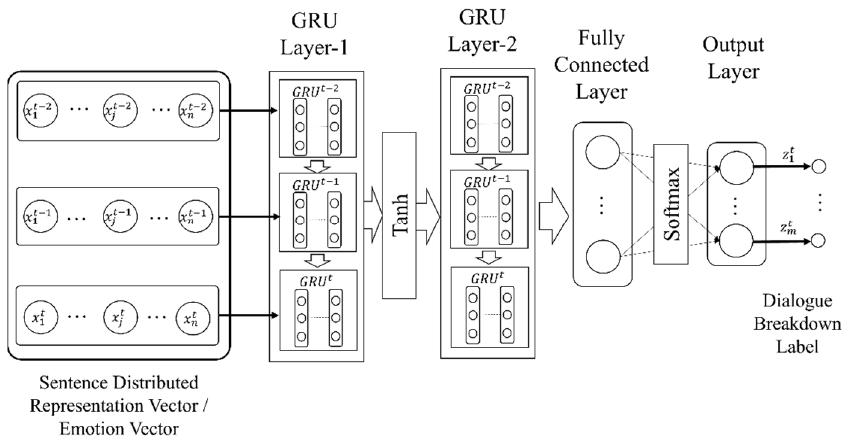
Figure 7. LSTM network using sentence vector or emotion vector as feature.